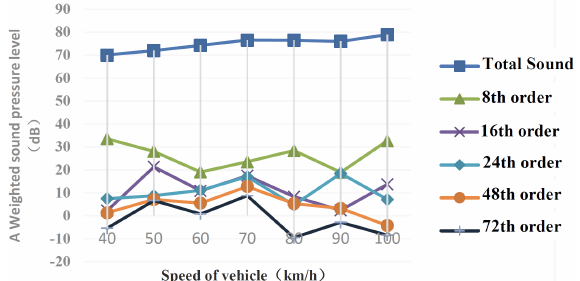
Fig. 10. Noise order analysis of right rear seat passenger's external ear (constant driving speed).